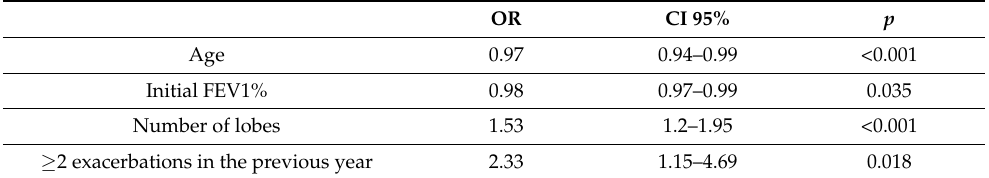
Table 2. Multivariate analysis of factors associated with CBI due to SA.